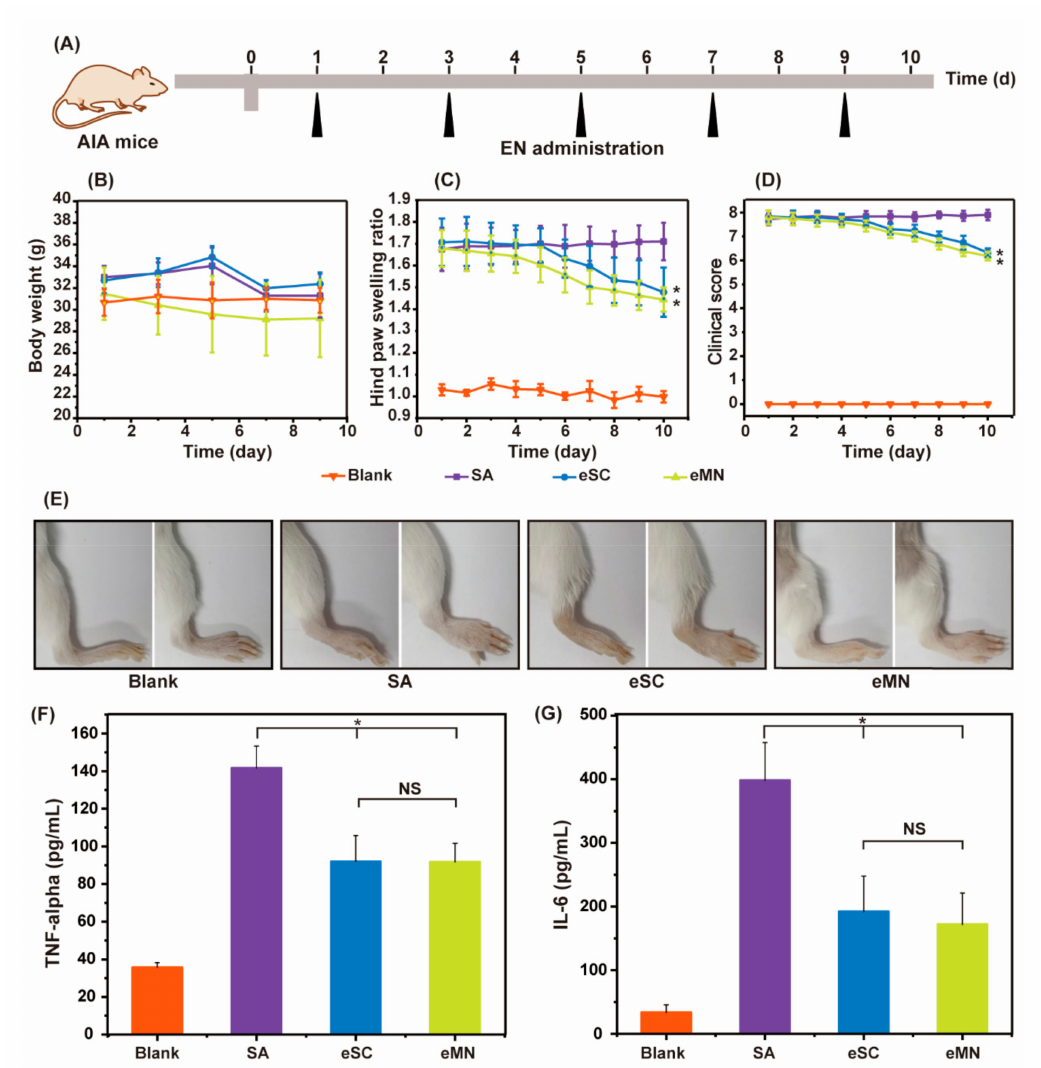
Figure 5. ( A ) The timeline of the animal experiment; ( B ) Body weight, ( C ) paw swelling ratio and ( D ) clinical score of AIA mice during 10 days of treatment using the listed treatment. ( E ) The frontal and profile images of hind paw of each group. ( F ) the TNF- α and IL-6 ( G ) concentration of serum after listed treatment. * p < 0.05 vs. SA. NS represents no